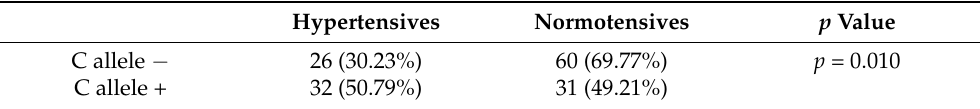
Table 8. The prevalence of arterial hypertension among patients with the C allele in the locus of rs